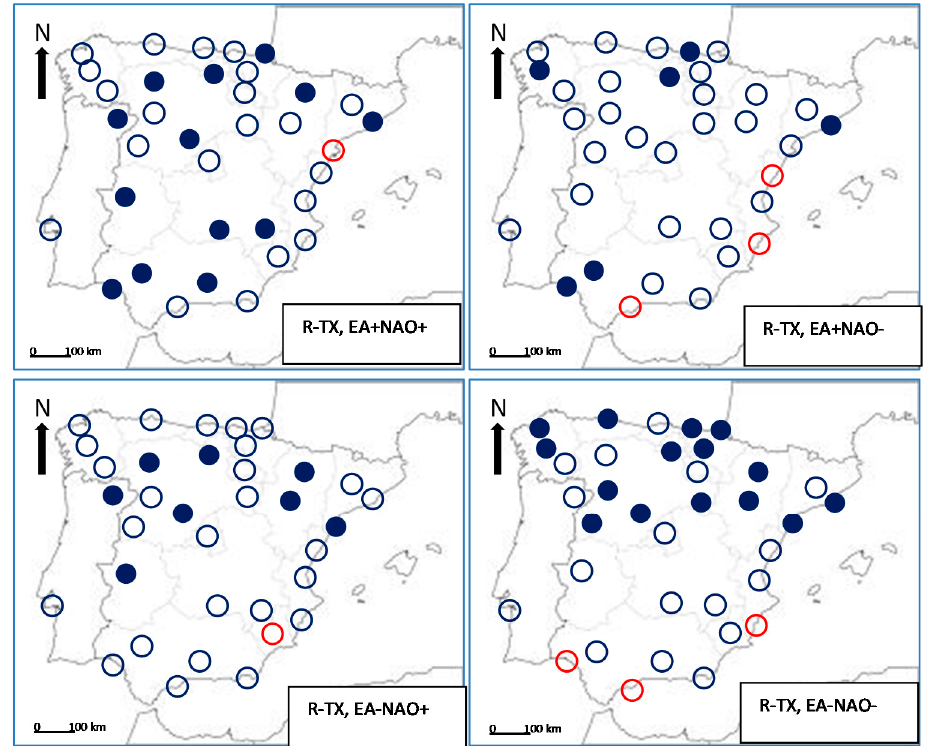
Figure 10. Correlation coefficients between TX and R under the four composites EA+NAO+, EA+NAO-, EA-NAO+ and EA+NAO+ for summer. Red: positive; blue: negative; full (empty): significant (non-significant) at the 95% confidence level.